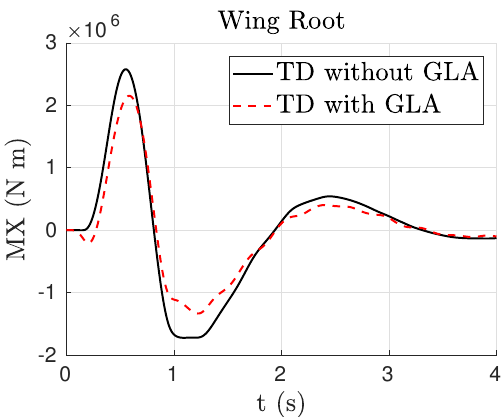
Figure 16. Time history of the incremental bending moment MX at the wing root with and without gust load alleviation (GLA)